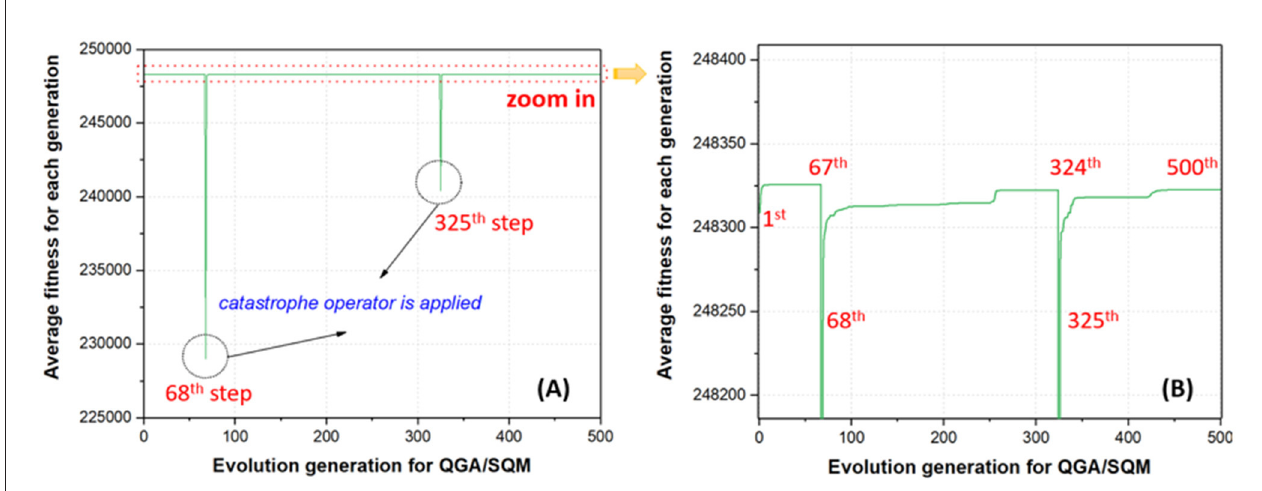
FIGURE 7 | Average fitness for the whole population along the quantum genetic algorithm (QGA)/semi-empirical quantum mechanics (SQM) evolution: (A) original curve and (B) local enlarged curve.